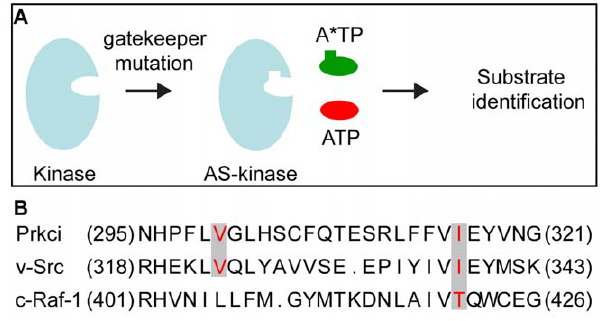
Figure 1. Design of the analog-sensitive Prkci. ( A ) A space- creating mutation (‘‘gatekeeper mutation’’) is introduced into the kinase ATP binding pocket which allows the analog-sensitive (AS) kinase mutant to accept a bulky ATP analog (A*TP) required for the chemical genetic identification of kinase substrates [modified after [36]]. ( B ) Alignment of the primary sequence of the ATP binding pocket within the kinase domains of Prkci, v-Src and c-Raf. The residues in red correspond to the amino acids mutated in v-Src [1], c-Raf-1 [28], and Prkci to enlarge the ATP binding pocket.